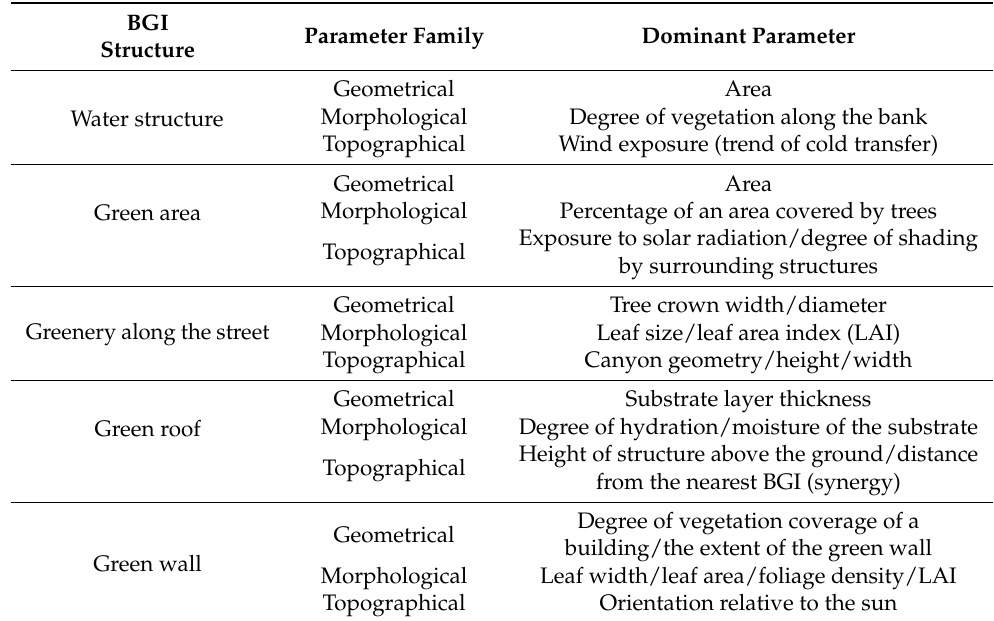
Table 1. The review of the blue-green infrastructure (BGI) element parameters relevant to urban heat island (UHI) effect mitigation [92].